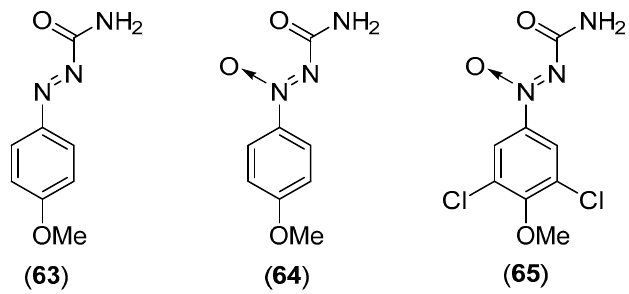
Figure 12. Chemical structures of selected compounds isolated from Lycoperdon pyriforme.